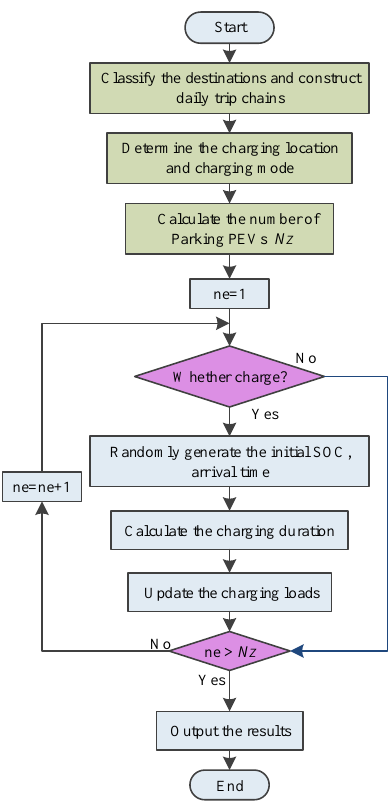
Figure 2. The determination of the spatial and temporal distribution of PEVs.